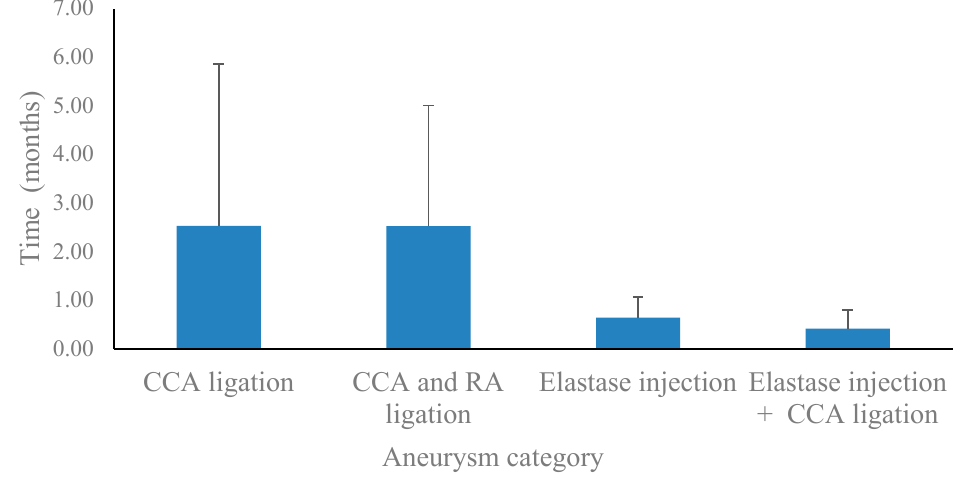
Figure 2. Meta-analysis of all intracranial aneurysm models to determine the shortest required study period for intracranial aneurysm (IA) generation. Common carotid artery (CA) ligation alone or in combination with renal artery (RA) ligation typically involved a period of several months, while intracranial aneurysms could be created by elastase injection with or without common carotid artery ligation in one month or less. Bars indicate mean +